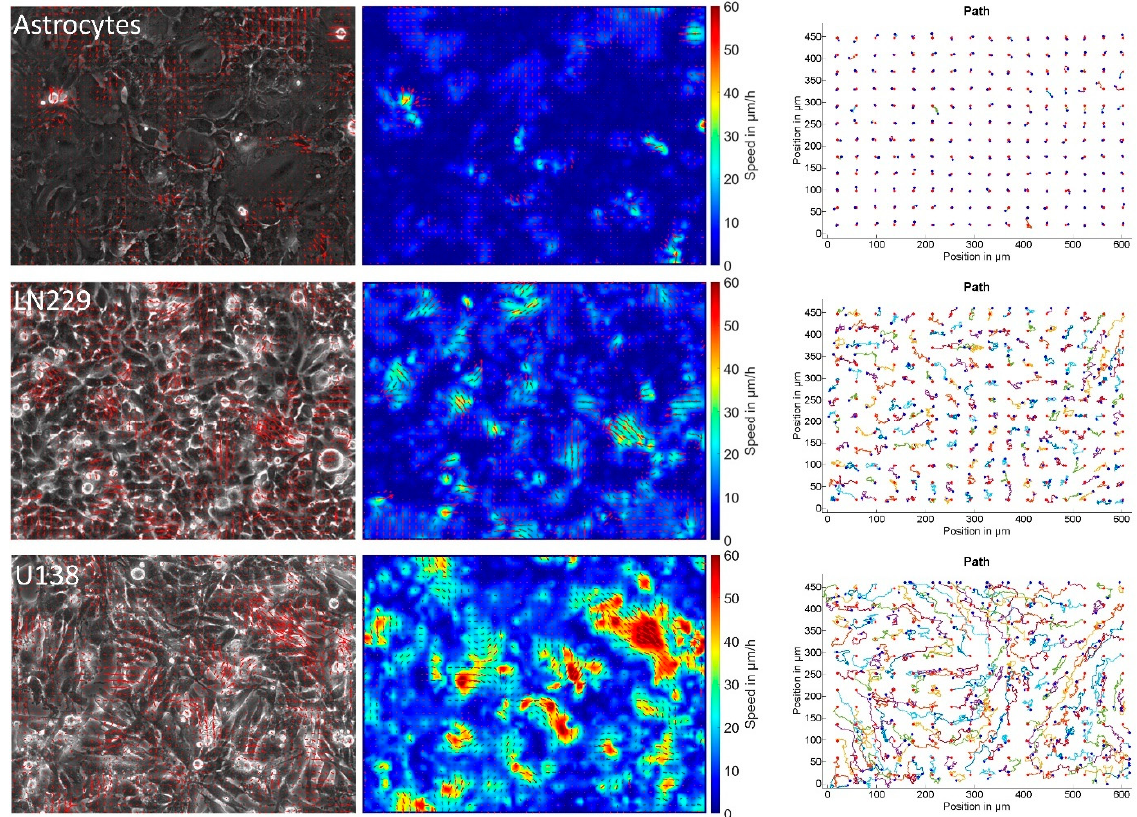
Figure 1. Migration of astrocytes and glioblastoma cells. Each row shows a typical phase contrast image, overlaid with the vectors of the velocity fields ( left ), the magnitude of the velocity and its direction ( center ) and typical cellular movement over the time course of 20 h ( right ). Red dots denote the start and blue dots the end position.